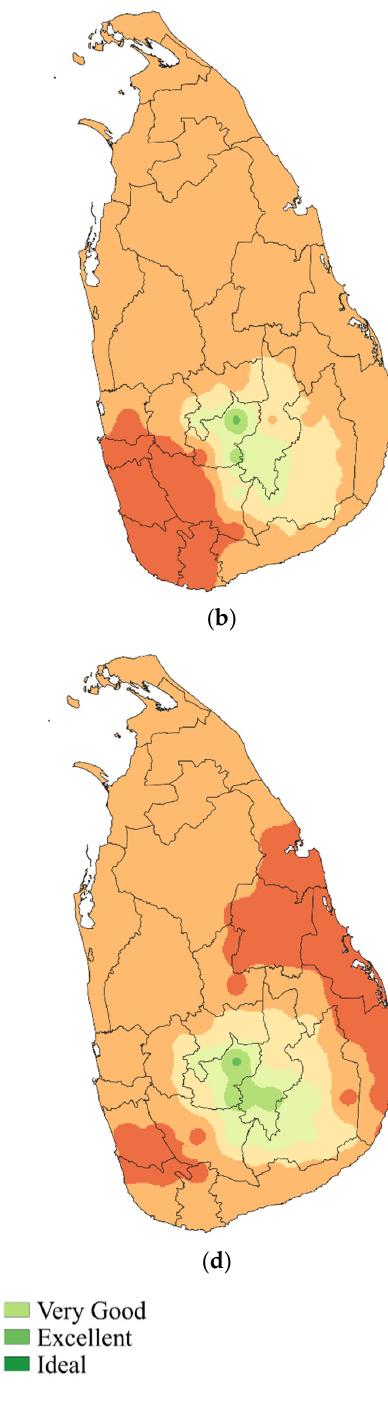
Figure 4. Spatial distribution of HCI Urban scores for 2010–2018: ( a ) For 1st Inter monsoon; ( b ) For Southwest monsoon; ( c ) For 2nd Inter monsoon; ( d ) For Northeast monsoon.